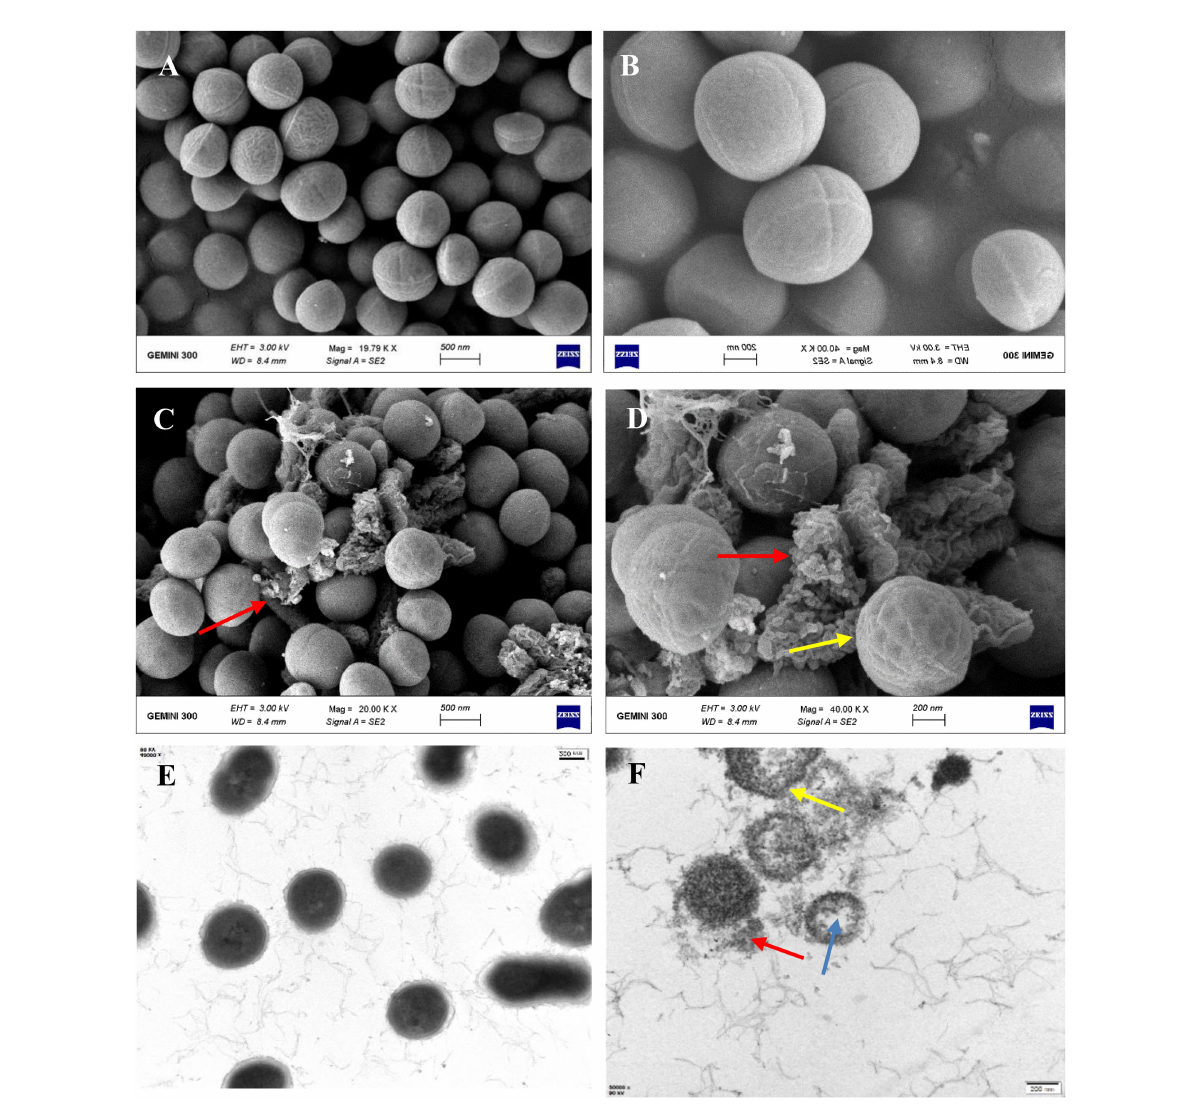
FIGURE 4 (A,B) The cell surface structure of untreated S. aureus D48 by SEM; (C,D) the characteristic of cell surface structure after treatment for 1 h by SEM (red arrows indicate broken cells; Yellow arrows indicate a wrinkled surface); (E) the cell surface structure of untreated S. aureus D48 by TEM; (F) the internal structural characteristics of cells after treatment for 1 h by TEM (blue arrows indicate intracellular cavities; yellow arrows indicate cell membrane holes; the red arrow indicates the outflow